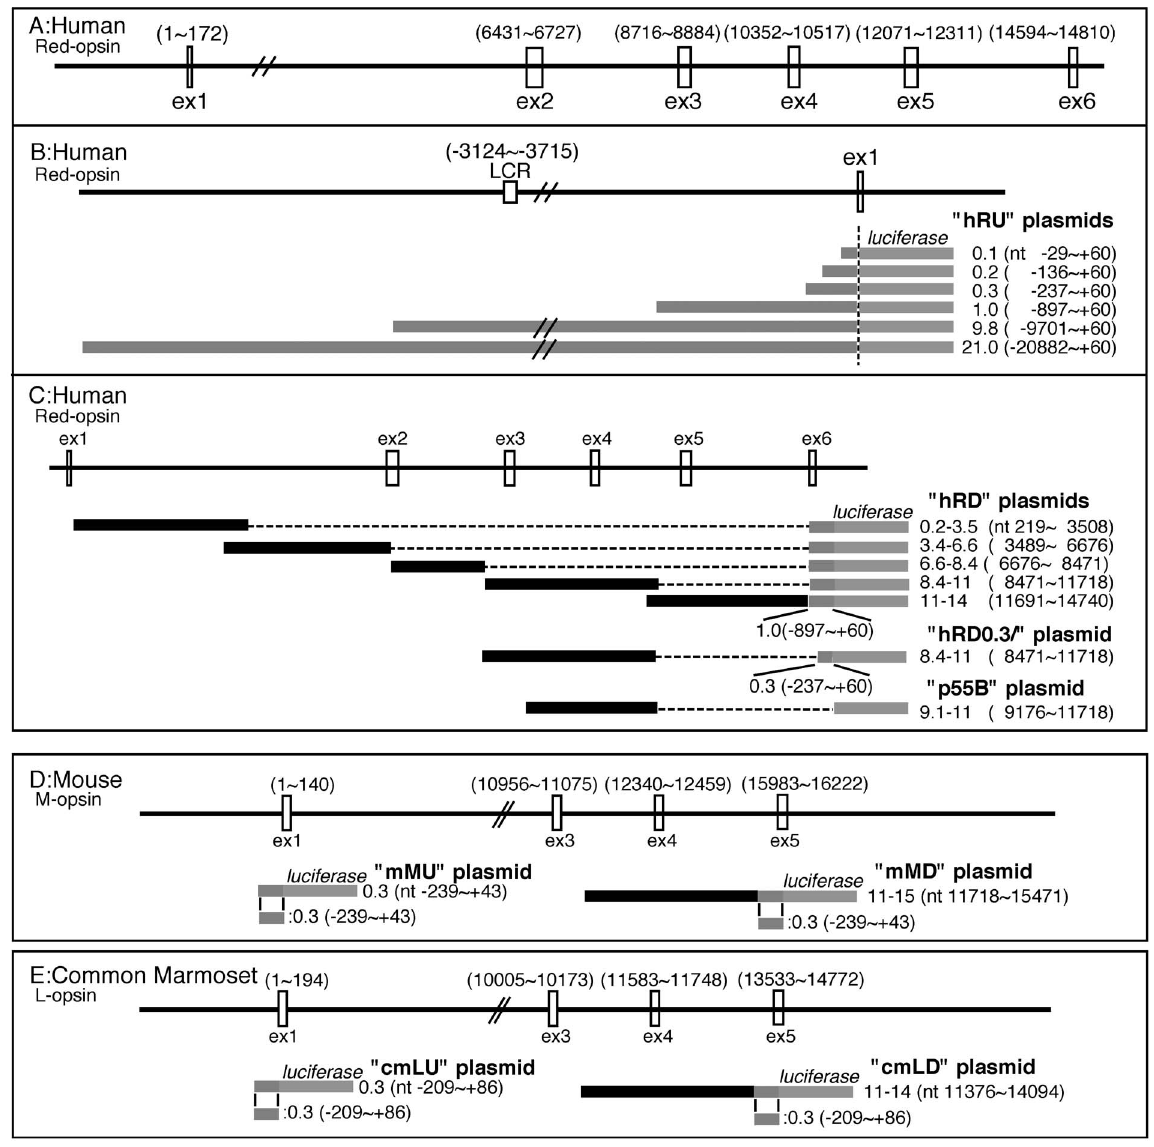
Figure 1. Schematic presentation of opsin promoter-luciferase constructs. A. Exon intron structure of human red opsin gene. B. Luciferase constructs of a serial deletion of 5 9 promoter region of human red opsin. C. Luciferase constructs containing various fragments from exon/intron region of human red opsin fused with 1.0 kb, or 0.3 kb of 5 9 promoter, or interferon promoter (p55B) region of human red opsin are shown. D. Upper diagram shows exon/intron structure of mouse M-opsin gene. Luciferase constructs of mouse M-opsin promoter are schematically shown in lower part. E. Upper diagram shows exon/intron structure of common marmoset red opsin gene, and luciferase constructs are schematically shown in lower part. Information of exon/intron structure was quoted from Sanger Institute public database, and TSS (transcriptional start site) is designated as nucleotide number 1. nt, nucleotide; ex, exon: LCR, locus control region.